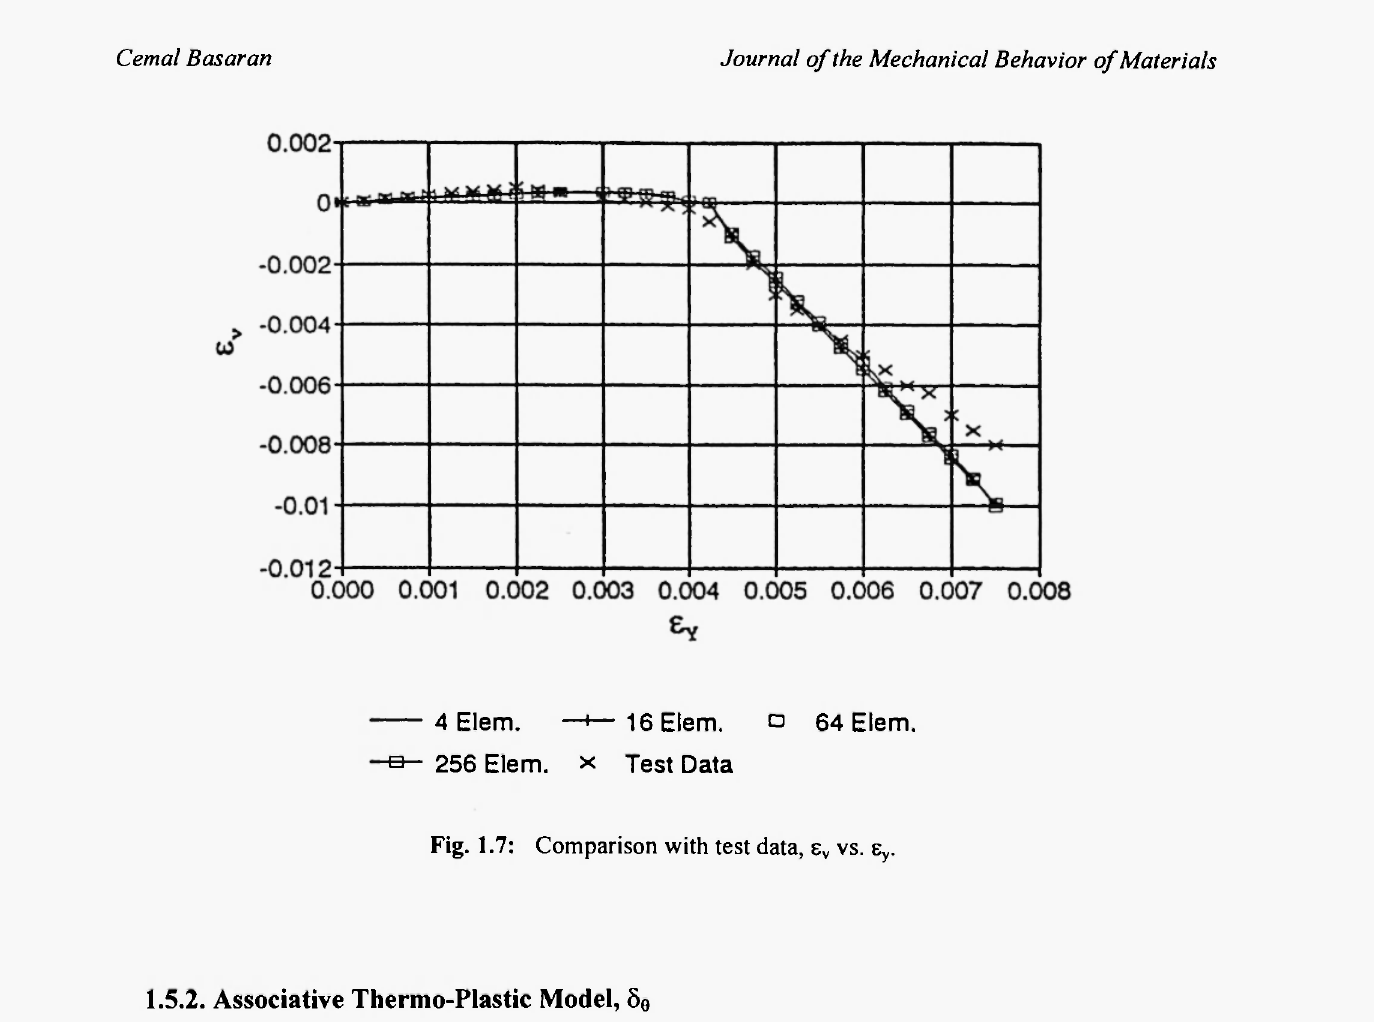
Fig. 1.7: Comparison with test data, ε ν vs. ε χ